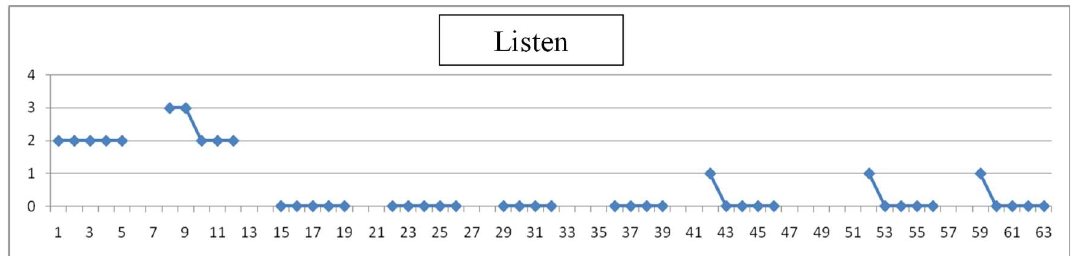
Figure 9. “Listen” reached soon a level of “no difficulty” with training.